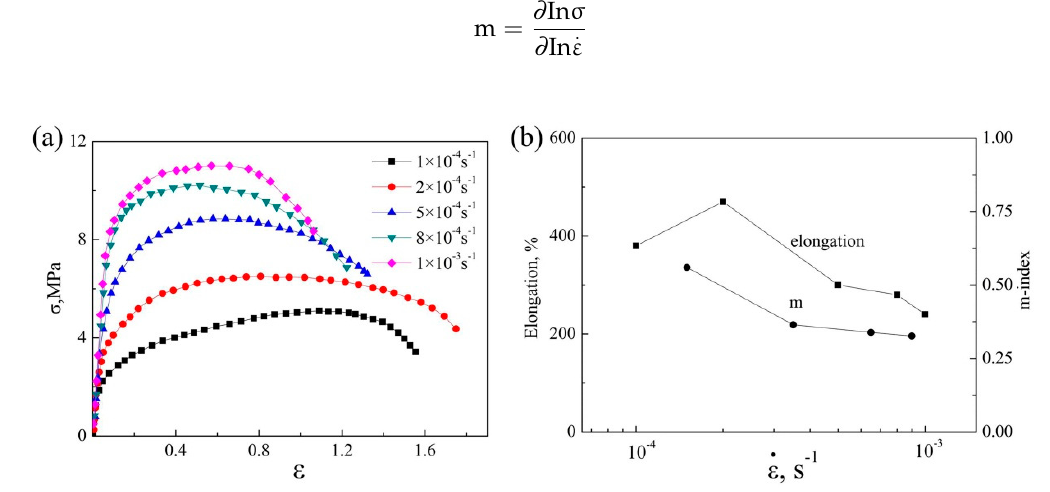
Figure 1. ( a ) The true stress–true strain curves and ( b ) the elongation and m-index at 490 °C of the